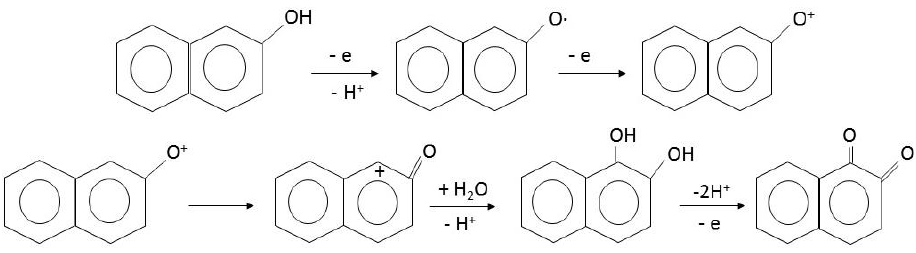
Figure 1. Two step oxidation process of β -naphthol [16].